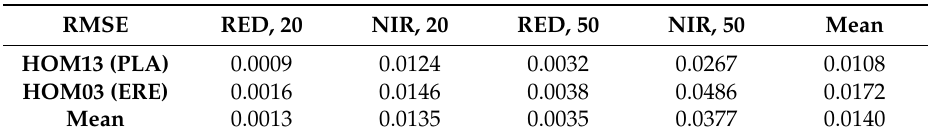
Table 2. Bidirectional reflectance factor (BRF) RMSE at the red and NIR band, two SZA (20 ◦ and 50 ◦ ) on HOM13 and